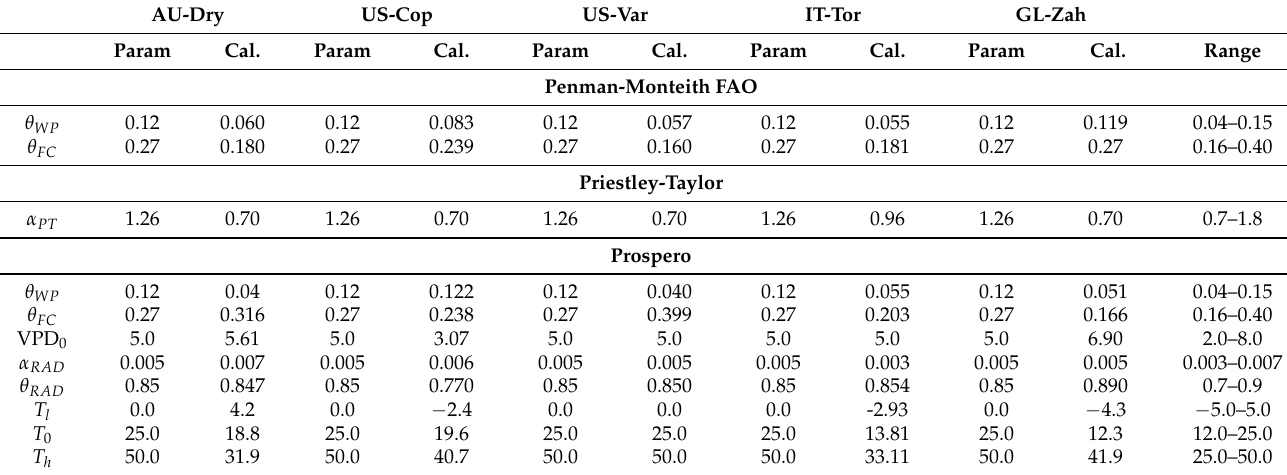
Table 3. Uncalibrated and calibrated values and range of the parameters of the three considered models, for each site. AU-Dry US-Cop US-Var IT-Tor GL-Zah Param Cal. Param Cal. Param Cal.